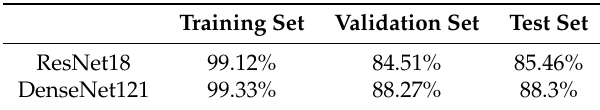
Table 1. Macro-averaged F1-scores for both architectures on the Classification task. The networks were initialized using weights obtained after training on the ImageNet